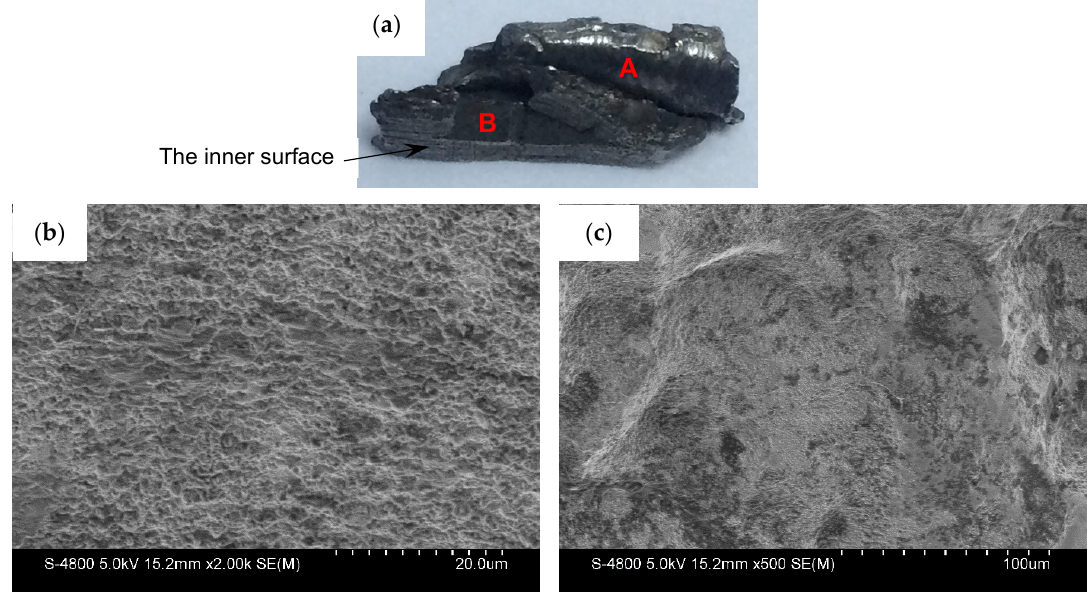
Figure 13. ( a ) Axial fracture surface of fragment from the detonation end of Specimen 1#; ( b ) metallurgical characterization of Site A in ( a ); ( c ) metallurgical characterization of Site B in ( a ).